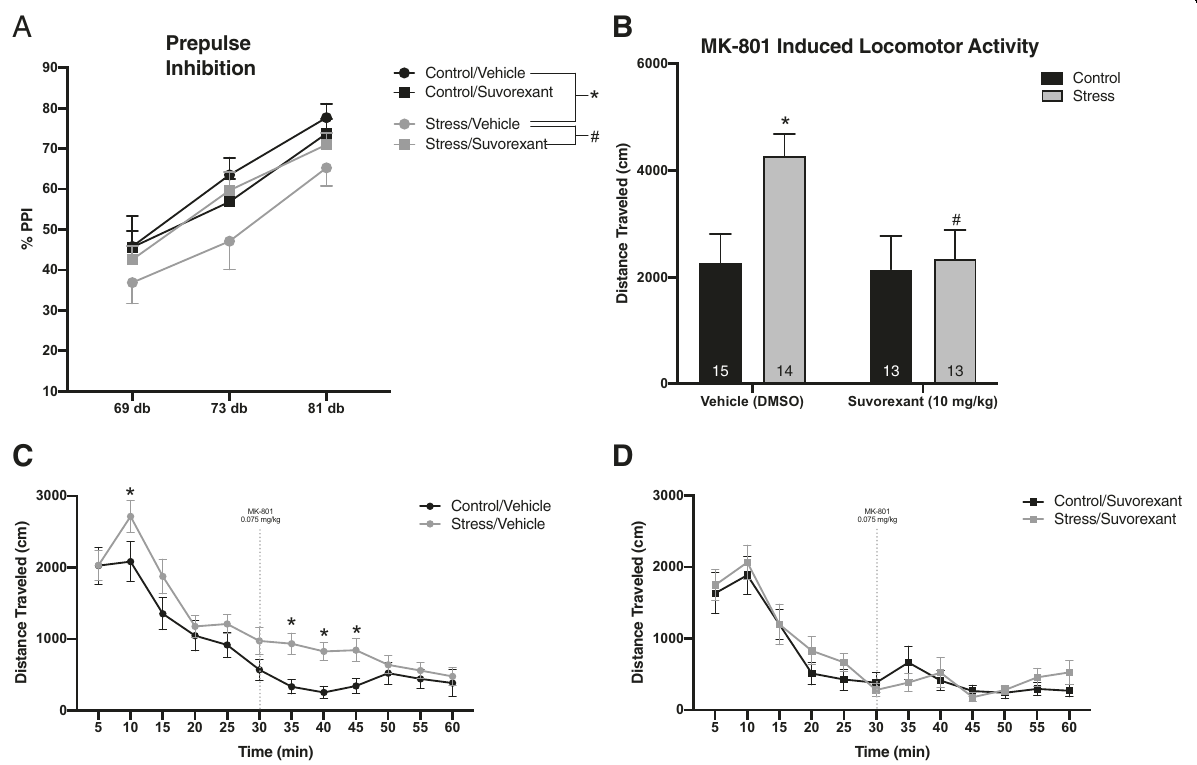
Fig. 2 Suvorexant alleviates behavioral de fi cits induced after two-day inescapable foot-shock. a Inescapable foot-shock produced de fi cits in sensorimotor gating in vehicle-treated rats. * p < 0.05 compared with control/vehicle. This de fi cit was reversed in rats that underwent two-day inescapable shock but were treated with Suvorexant. # p < 0.05 com p ared with stress/vehicle. n = 16 rats per group. Additionally, inescapable foot- shock induces hyperlocomotion following MK-801 administration which is reversed following administration of Suvorexant ( b – d ). b Total distance traveled after MK-801 administration was signi fi cantly higher in rats that received inescapable foot-shock. * p < 0.05 compared with control/vehicle. Hyperlocomotion was reversed in stressed animals treated with Suvorexant. # p < 0.05 compared with stress/vehicle. c Distance traveled before and after MK-801 administration in vehicle-treated rats. Stressed rats displayed sustained hyperlocomotion after MK-801. * p < 0.05 compared to control/ vehicle. d Rats treated with Suvorexant showed no differences in baseline activity or activity following MK-801. n = 13 – 15 rats per